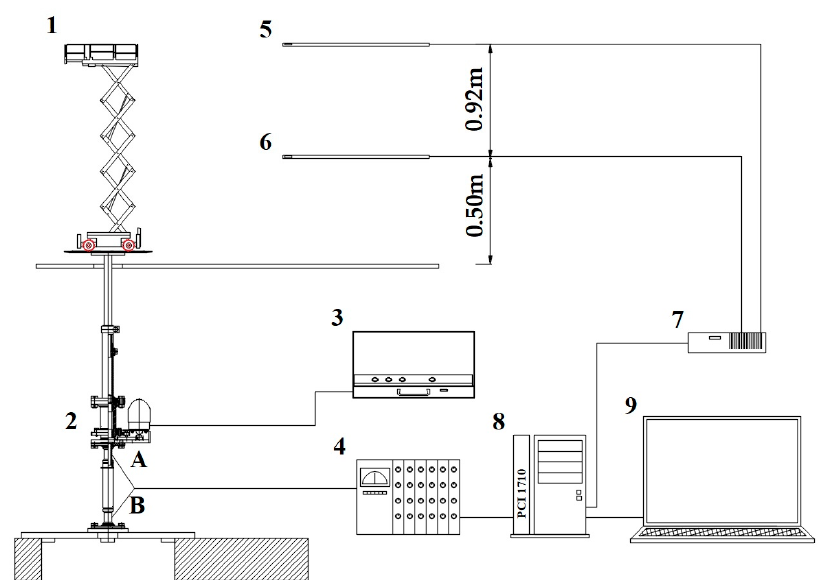
Figure 6. The schema of the measuring system (1—the scissor lift, 2—the aerodynamic balance, 3—the electronic system, 4—the stepper motor, 5 and 6—the thermo-anemometer probes, 7—the thermo-anemometer, 8—PCI 1710 card, 9-PC, and A, B—the segments with strain gauges).